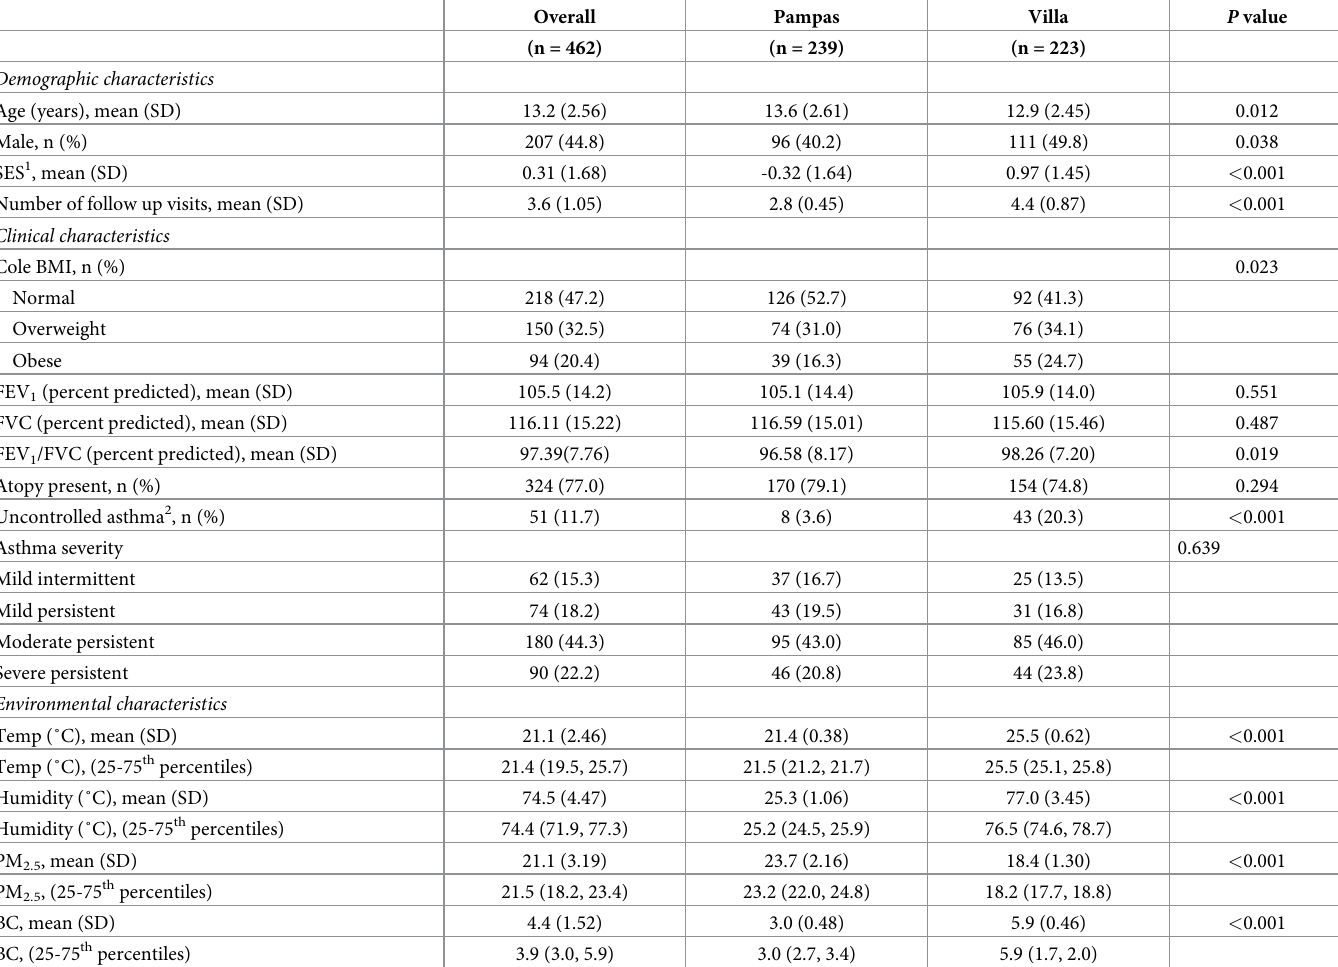
Table 1. Baseline demographic and clinical characteristics of asthmatic children overall and by